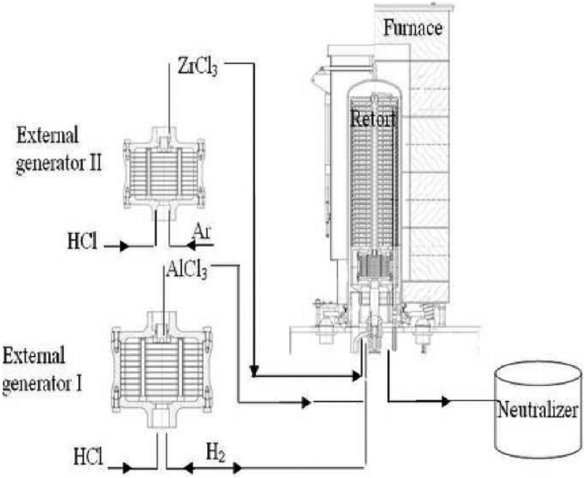
Fig. 4: The schematic presentation of the CVD equipment BPXPR0325S manufactured by IonBond Company [10]. (Fig. 4), at 330 °C according to the reaction: 2Al + 6HCl → + 3H 2AlCl . Then the saturating atmosphere was trans- 3 2 ported in a stream of hydrogen gas into the CVD reactor, where nickel samples were placed.